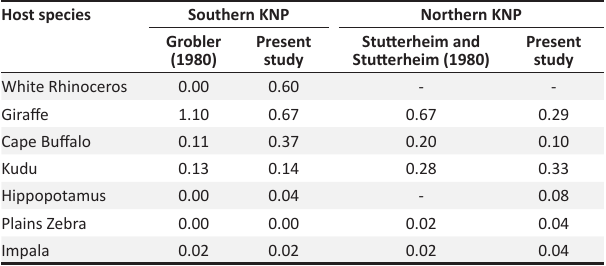
TABLE 1: Host preference indices from this study, compared to previous studies in the Kruger National Park. Host species